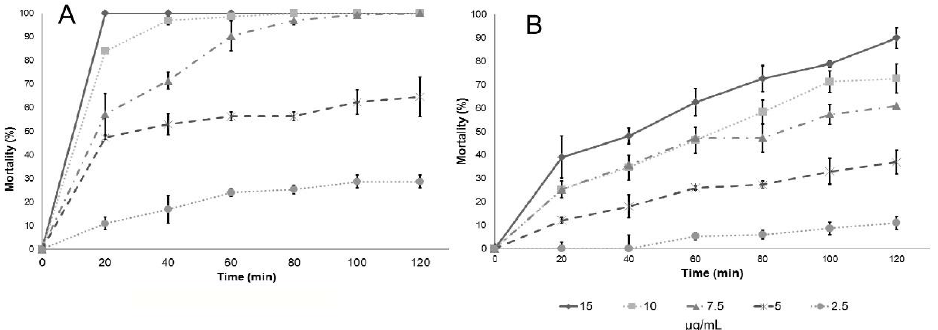
Figure 2. Effect of dose and incubation time on larval mortality of: ( A ) anise ( Pimpinella anisum Linneaus) essential oil; and ( B ) trans -Anethole.